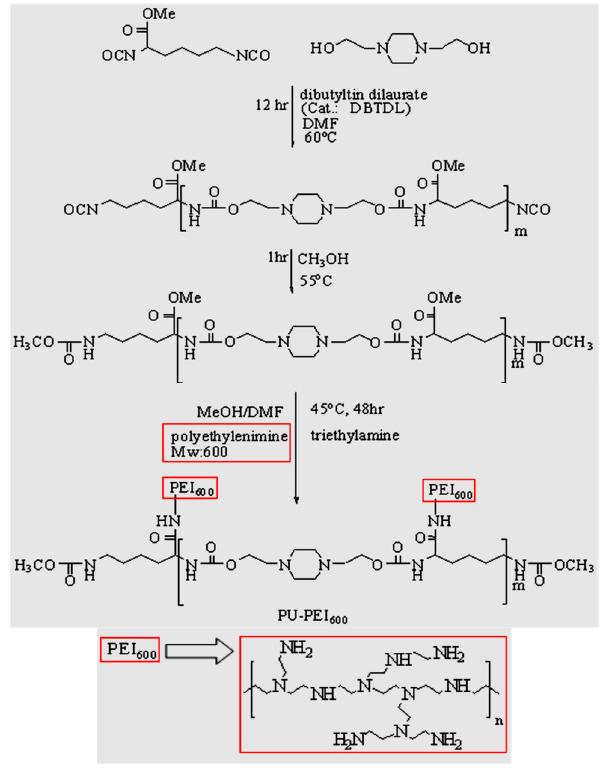
Scheme 1. Synthesis of polyurethane grafted polyethylenimine (PU-PEI 600